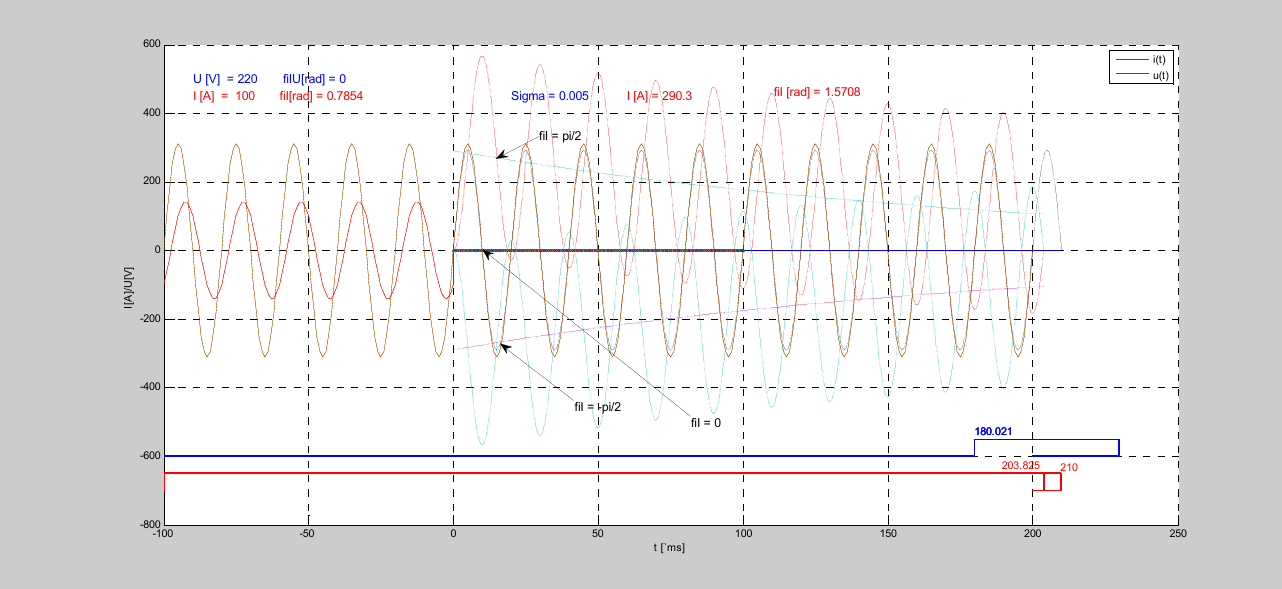
Figure 19. Transient switching diagram for capacitive, resistive and inductive load, ɸ I def = −π /2; 0; π /2, for I def = 290.3 A, σ = 0.005, t command = 180.021 ms, t dconnect = 203 ms.